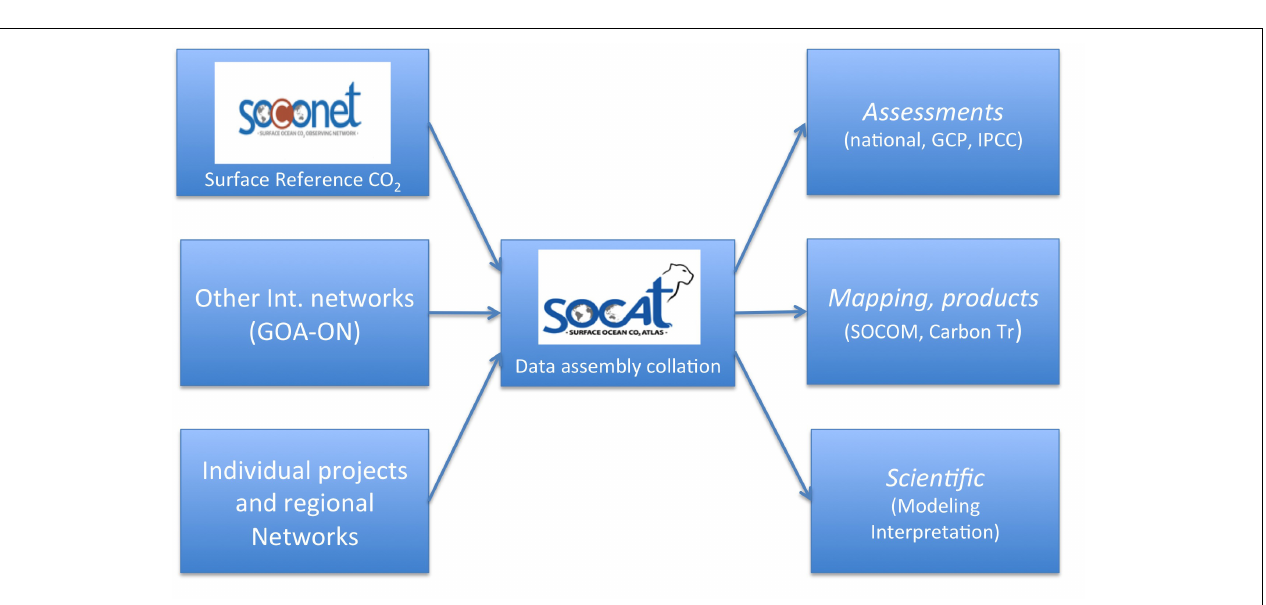
FIGURE 1 | Schematic how SOCONET and MBL CO 2 data will contribute to the creation of surface ocean pCO 2 maps and CO 2 flux maps. The blue boxes indicate data products and the light green boxes indicate the manipulations/calculations to the maps. This conceptual drawing indicates the many steps necessary to go from observations to products.